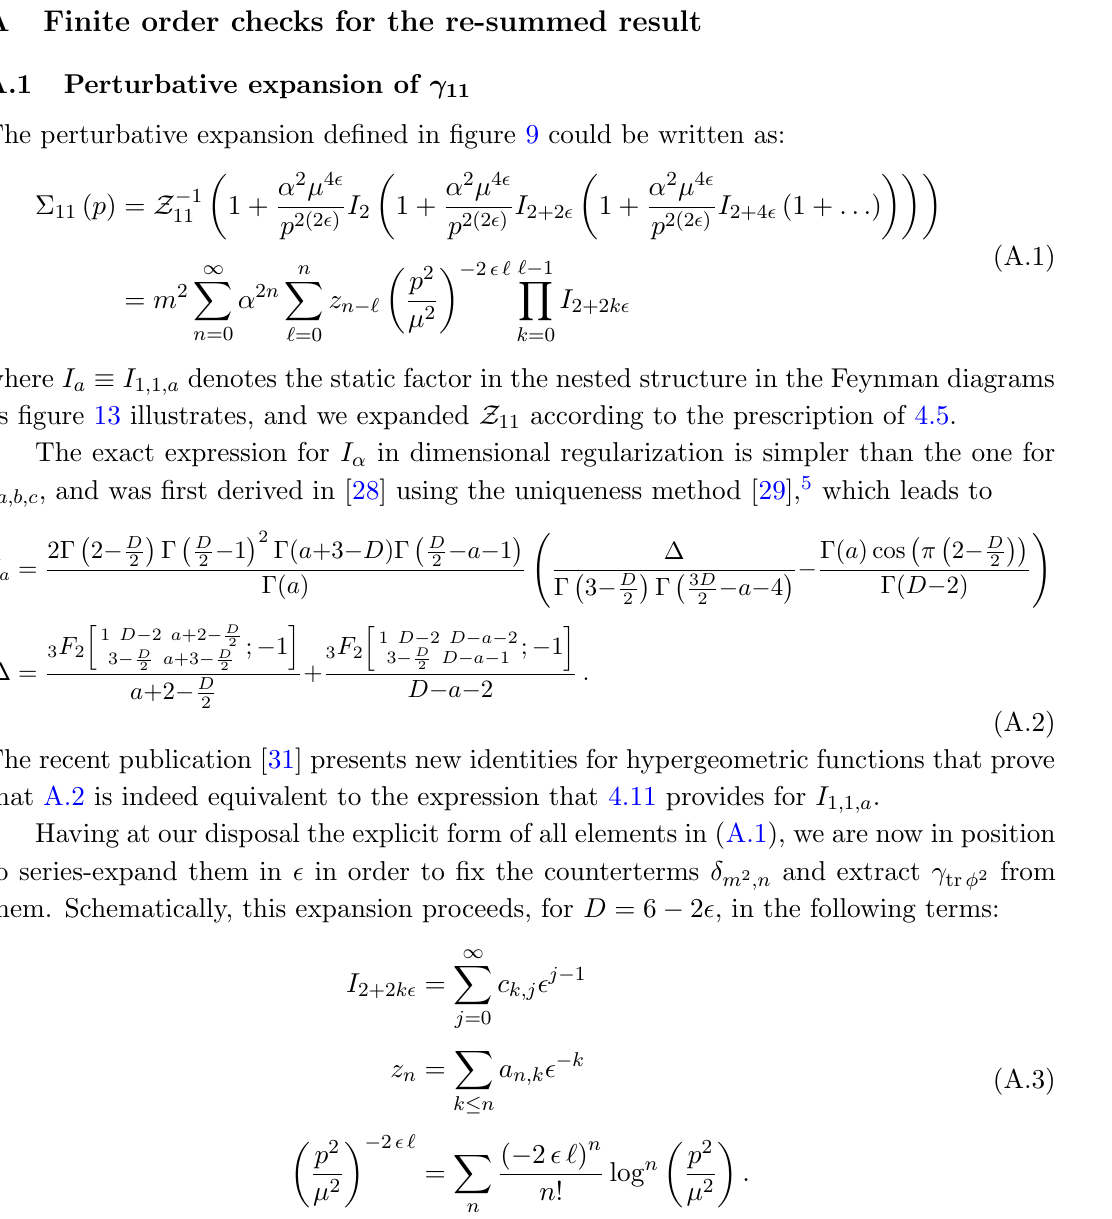
Figure 13 . Elementary building block in the nested sequence depicted in (cid:12)gure 9, and the value of its amputated Feynman integral. When the additional legs is taken into account, a generic diagram of the sequence becomes a product of I 2+2 k(cid:15) factors in D = 6 (cid:0) 2 (cid:15) dimensions, with the corresponding (cid:11) and p 2 =(cid:22) 2